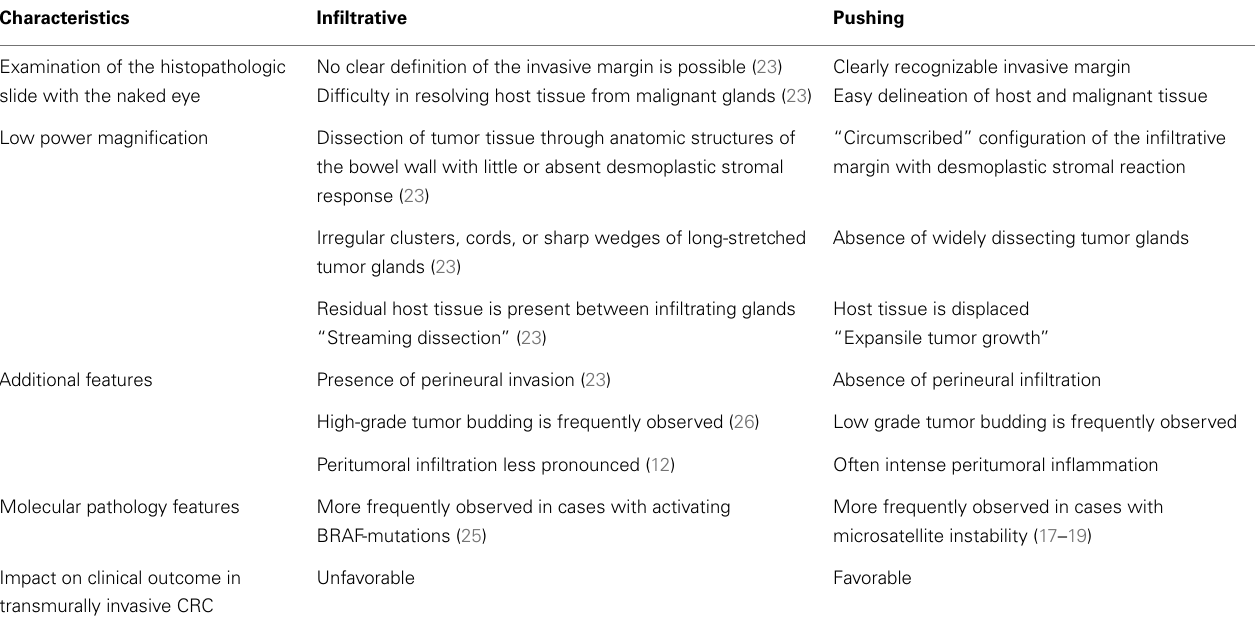
Table 3 | Contrasting features of primary colorectal cancers depending on the tumor border